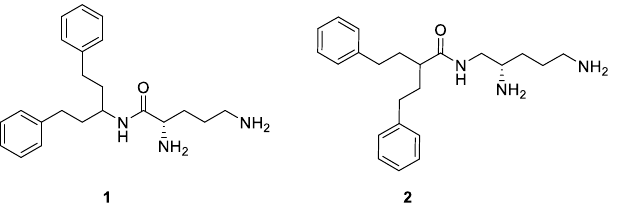
Figure 2. Structures of the two-aryl alkyl diaminopentanamide potentiators.